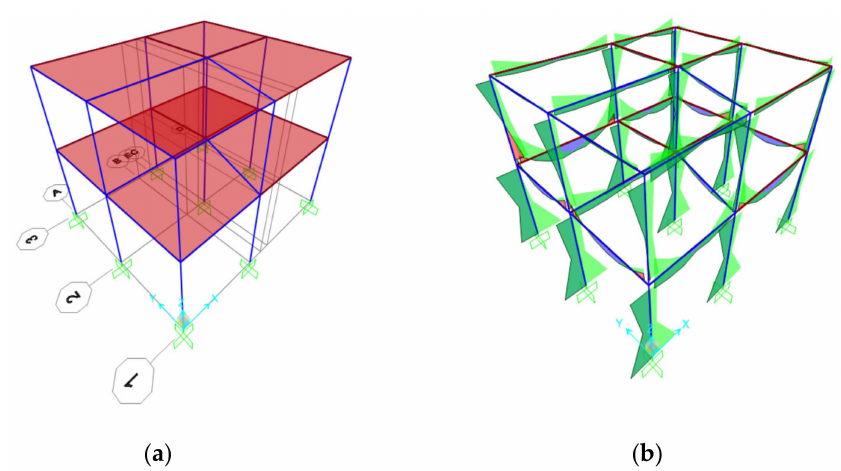
Figure 4. Structural analysis in SAP2000: ( a ) moment-resistant frame with reinforced concrete elements, ( b ) moment diagram obtained with load